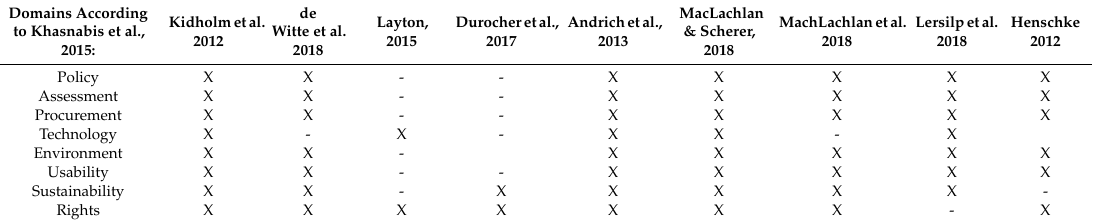
Table 1. Template of each included article’s content, referring to Khasnabis et al. [14]. Domains According to Khasnabis et al.,